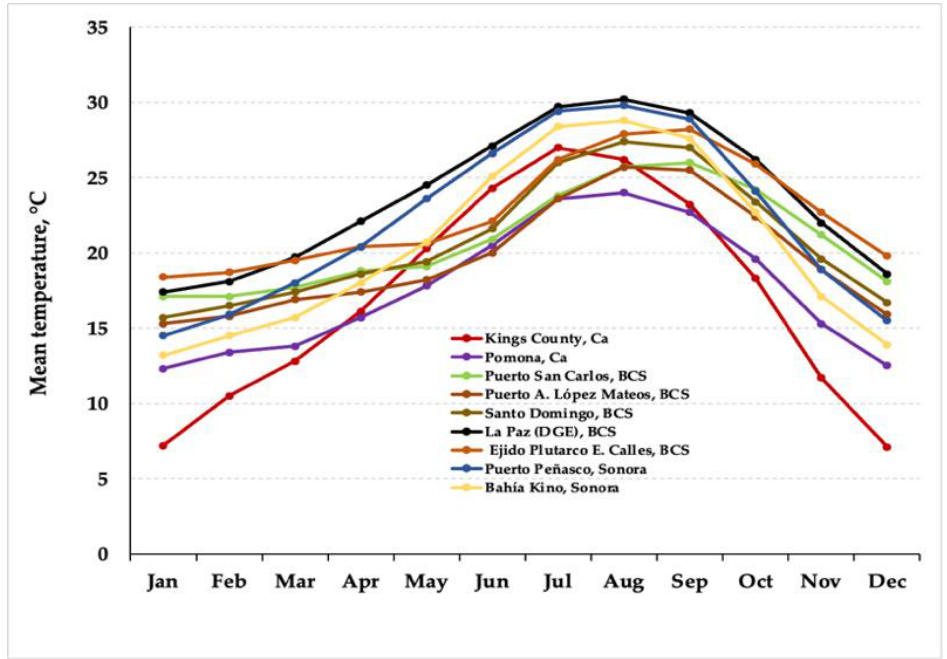
Figure 4. ( a ) Historical mean temperature data from six stations in the western region of Mexico (Jalisco, Michoacán, and Guanajuato); and ( b ) from nine stations in the Valley of Mexico and the central-eastern region of Mexico (Tlaxcala, Puebla, Hidalgo, Mexico City, and Mexico State), where Suaeda edulis is reported.